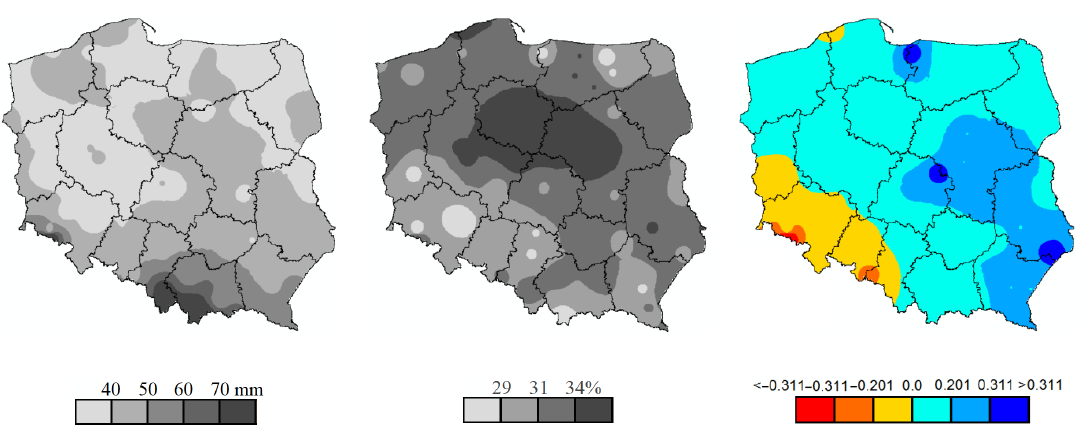
Figure 5. Variability and trend of total spring (March–May) precipitation in Poland. Years 1951 – 2018.